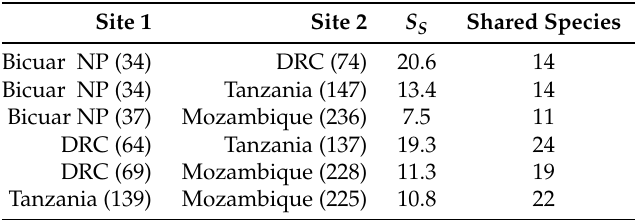
Table 4. Pairwise beta diversity comparison of plot groups measured by the Sørensen coefficient ( S s ) of percentage similarity of aggregated plot level data from each of the four sites. Values in parentheses are the number of species unique to each site in each comparison.